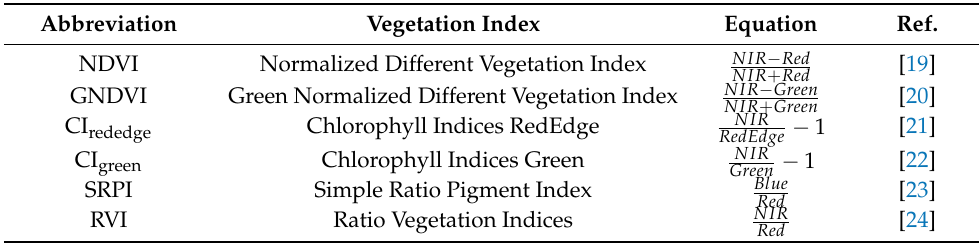
Table 1. Vegetation indices for the remote assessment and monitoring of phosphate-solubilizing bacteria in the common bean.